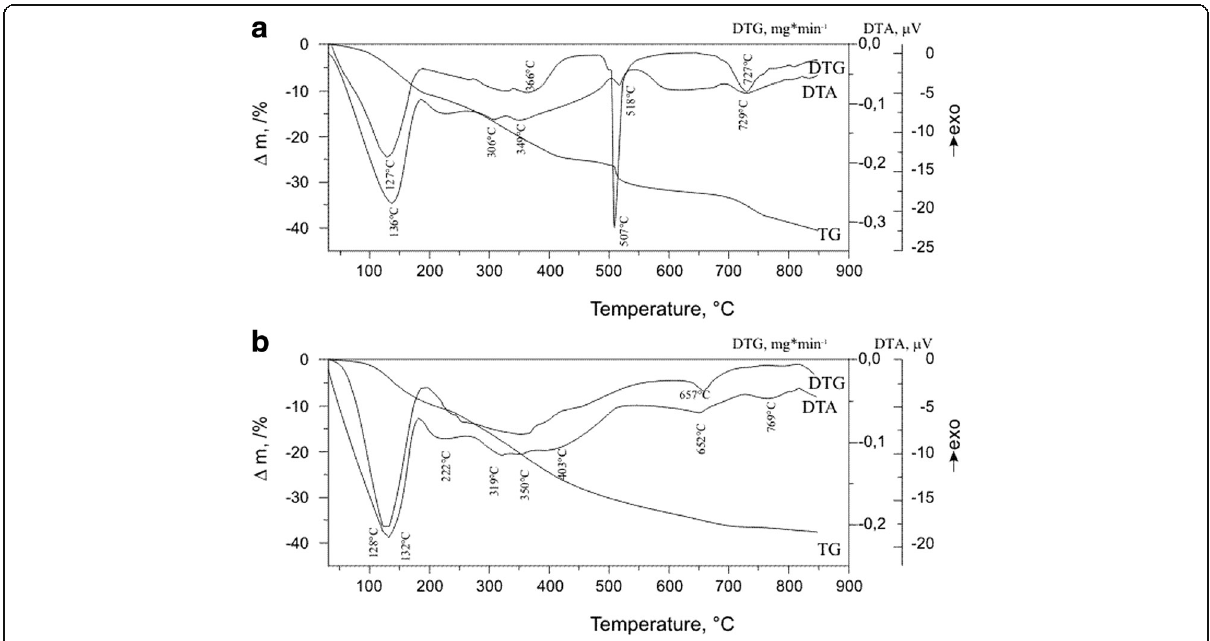
Fig. 2 TG, DTG, and DTA curves of Nd(alacac) 3 ( a ) and [Nd(alacac) 3 ] n ( b